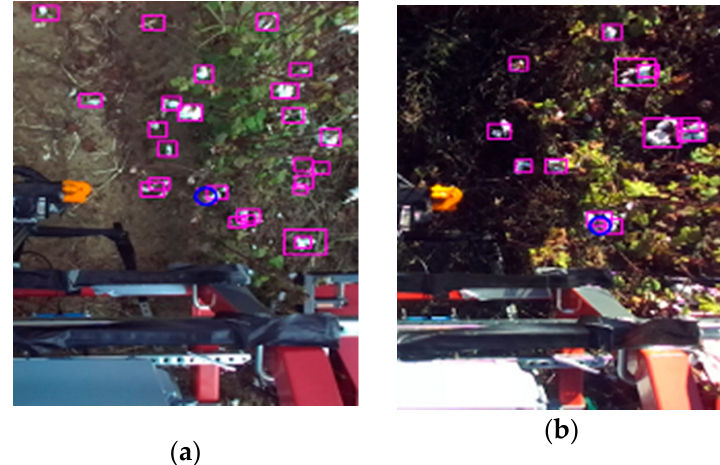
Figure 9. Boll detection using tiny YOLOv3 and ZED camera. ( a ): cloudy day. ( b ): sunny day.